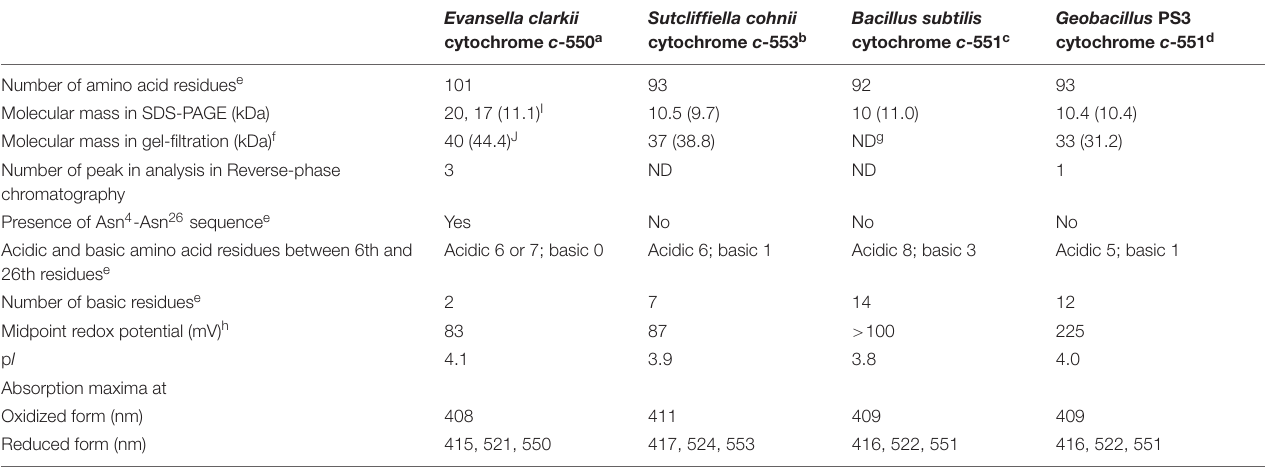
TABLE 1 | Biochemical properties of membrane bound cytochromes c of obligate alkaliphilic Evansella clarkii , facultative alkaliphilic Sutcliffiella cohnii , and neutralophilic Bacillus subtilis, and Geobacillus PS3.